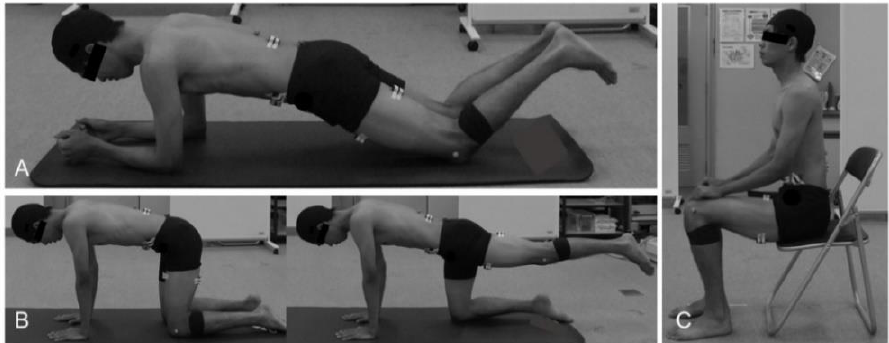
Figure 2. Trunk stabilization exercises ( A , B ) and chair sitting position ( C ). ( A ) Elbow-knee position, ( B ) hand-knee position with left lower extremity extension, and ( C ) chair sitting position.